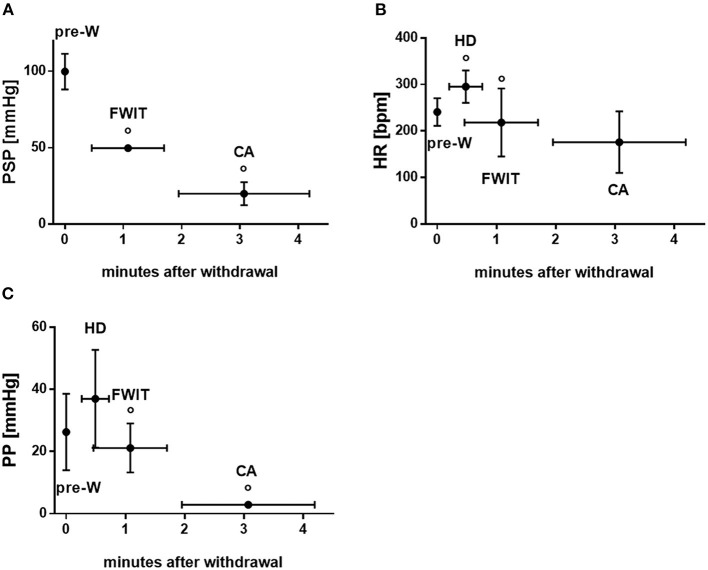
Functional parameters during in-situ/withdrawal phase. (A) Peak systolic pressure (PSP) (B) heart rate (HR) (C) pulse pressure (PP). CA, circulatory arrest; FWIT, functional warm ischemia start; HD, hyperdynamic phase; pre-W, pre-withdrawal of life sustaining therapy. Data are expressed as mean ± standard deviation. Statistical analyses were only performed between consecutive time points. °p < 0.05 vs. corresponding previous time point. n = 10–21/time point.